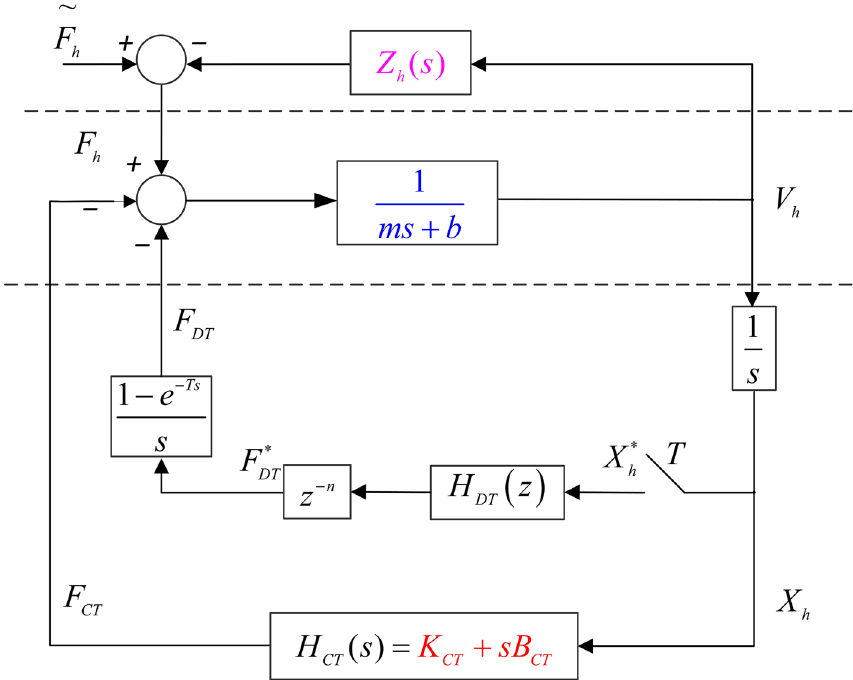
Figure 2. A single-user haptic virtual surgery simulation system with a hybrid controller